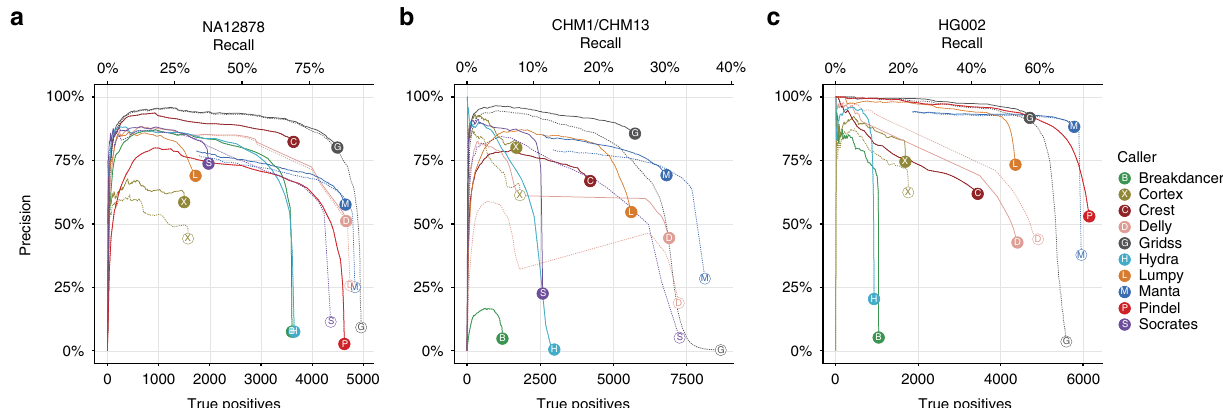
Fig. 1 Performance varies widely among callers, but the assembly-based callers manta and GRIDSS consistently perform well. For each caller, the precision (1-false discovery rate) is plotted against the number of true positives/recall as variant quality threshold varies. The read count is used as a proxy for quality when quality score is not reported. Some callers report all calls and stratify them into pass (which can be considered as high con fi dence) and non- pass (low con fi dence), while others report only pass calls. Filled circles and solid lines correspond to calls with PASS or “ . ” in the VCF FILTER fi eld. Open circles and dashed lines correspond to including all calls (passed or not). The ideal caller would have a dot close with precision close to 100% and a dot as far right as possible. Each plot corresponds to a distinct human cell line and truth set: a NA12878: 50× coverage, 2 × 101 bp, hg19, 319 bp median fragment length; b synthetic diploid CHM1/CHM13: 80× coverage, 2 × 151 bp, hg38, 345 bp median fragment length; c HG002 60× coverage, 2 × 151 bp, hg19, 555 bp median fragment length. HG002 calls have been fi ltered to only regions that the truth set de fi nes as high con fi most variable performance: on the 2 × 101 bp reads from